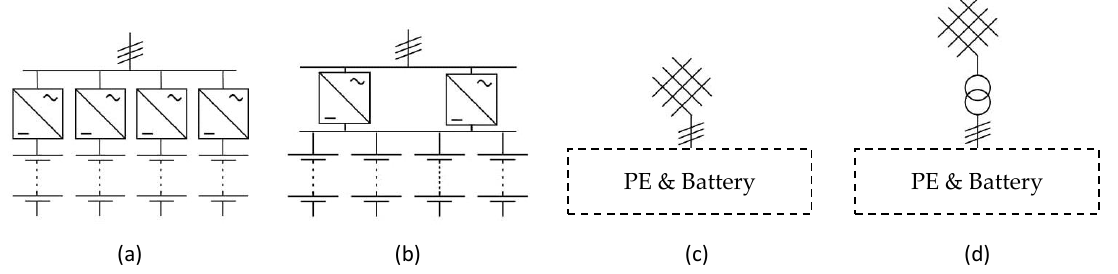
Figure 5. Overview of variants of power electronics topologies: ( a ) dedicated and ( b ) parallel connection. Direct grid connection ( c ) and connection via transformer link ( d ) is